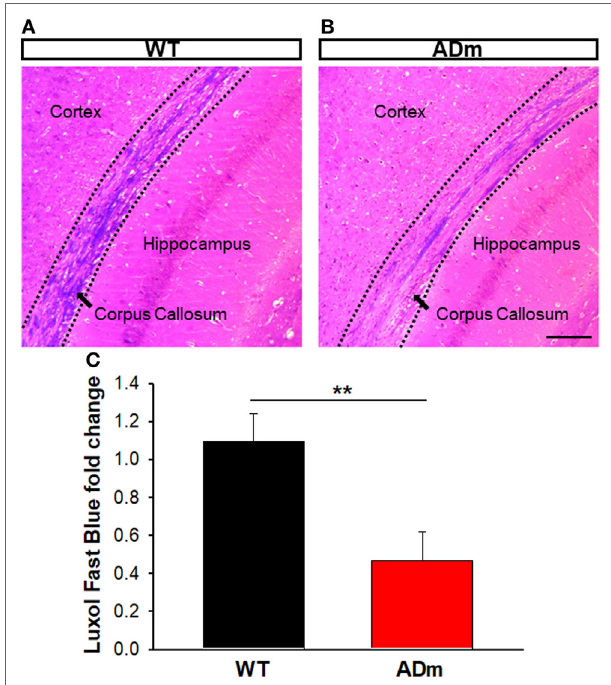
FigUre 6 | Myelin staining. Coronal sections of paraffin-embedded brains from WT mice (a) and ADm mice (B) exposed to RA were stained with Luxol Fast Blue. Scale bar 250 µm. (c) Quantification of the Luxol Fast Blue fold change (myelin) in WT tissue (black bar) and in ADm tissue (red bar) using Image J software. ADm mice showed a statistical significant decrease in the levels of brain myelin compared to the control mice, WT. t -Test, ** p < 0.01. Data are presented as mean ± SE. WT, wild type; ADm, Alzheimer’s disease transgenic mouse; RA, room